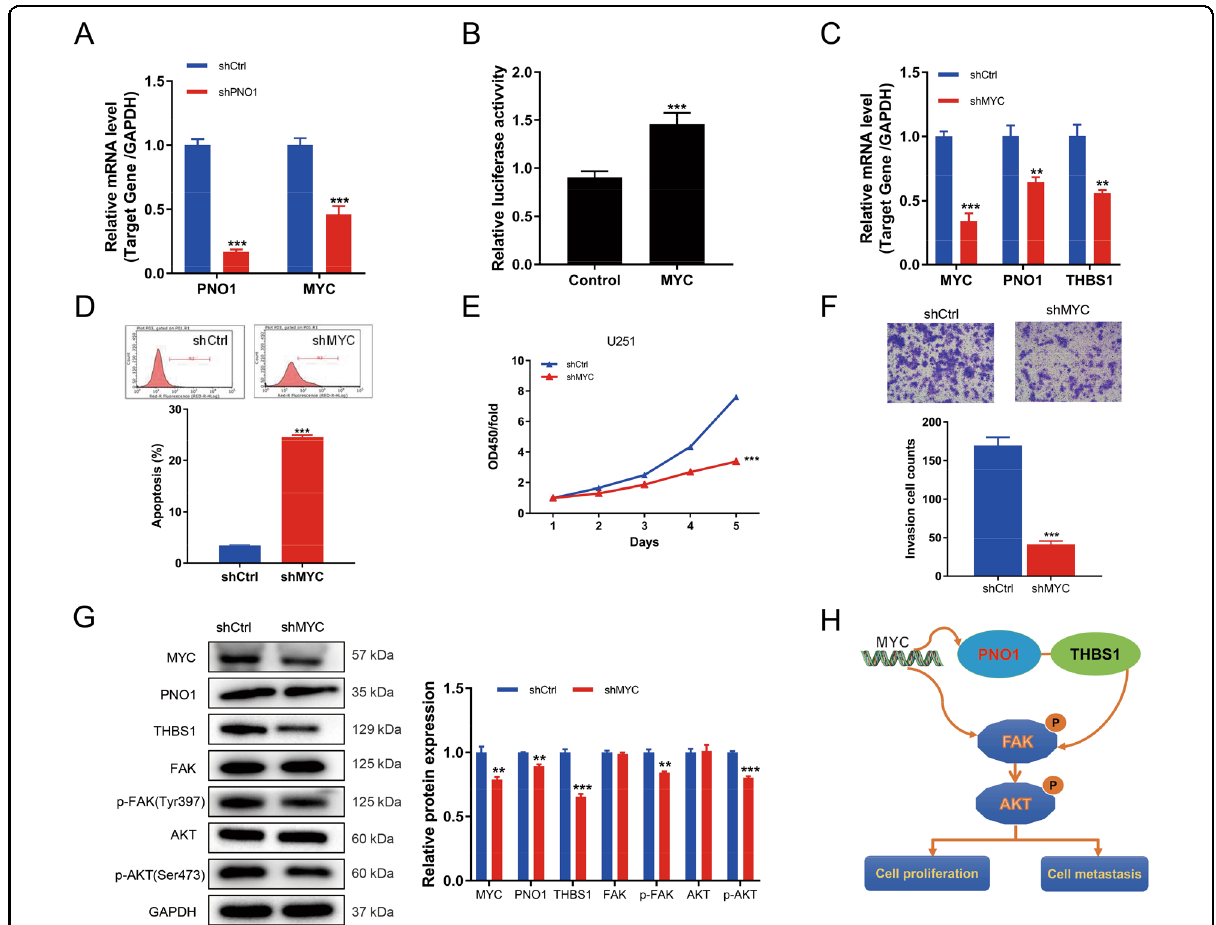
Fig. 7 Transcription factor MYC positively regulates PNO1 expression in glioma. A RT-PCR showing PNO1 and MYC mRNA levels in U251 cells infected with shCtrl or shPNO1. n = 3, *P < 0.05, **P < 0.01, *** P < 0.001. B A dual luciferase assay was performed to determine the effect of MYC overexpression on transcriptional activity of PNO1 in U251 cells. C RT-PCR showing MYC, PNO1 and THBS1 mRNA levels in U251 cells infected with shCtrl or shMYC. n = 3, **P < 0.01, *** P < 0.001. D Effects of MYC on cell apoptosis of U251 cells infected with shCtrl or shMYC. n = 3, ***P < 0.001. E Effects of MYC on growth of U251 cells infected with shCtrl or shMYC. n = 3, ***P < 0.001. F Effects of MYC on cell invasion of U251 cells infected with shCtrl or shMYC. n = 3, ***P < 0.001. G Western Blotting showing MYC, PNO1, THBS1 and FAK/AKT signaling protein levels in U251 cells infected with shCtrl or shMYC. H Schematic depicting the regulation of PNO1 in GBM